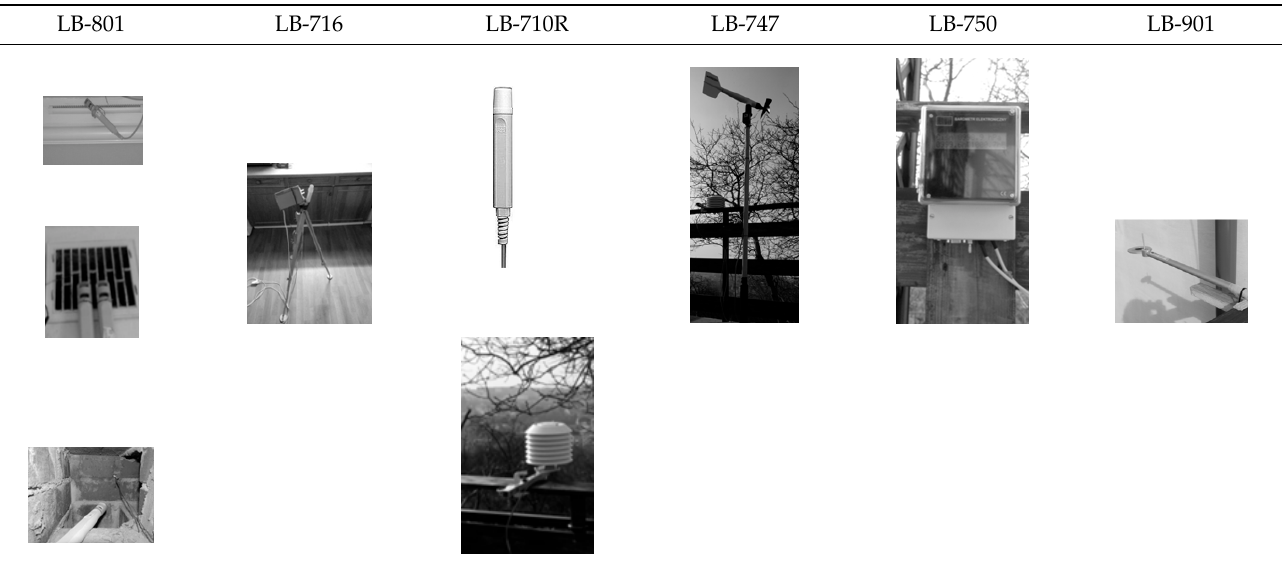
Table 3. The sensors used during in experiment.